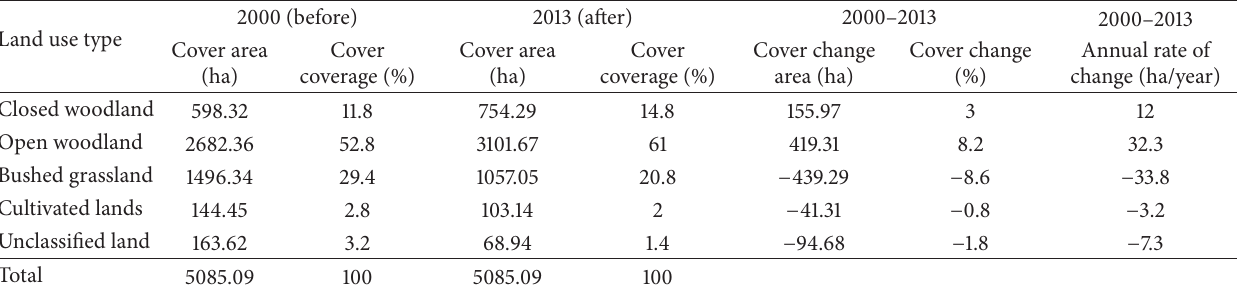
Table 5: Land use and miombo cover change before and after CBFM, Kidundakiyave.